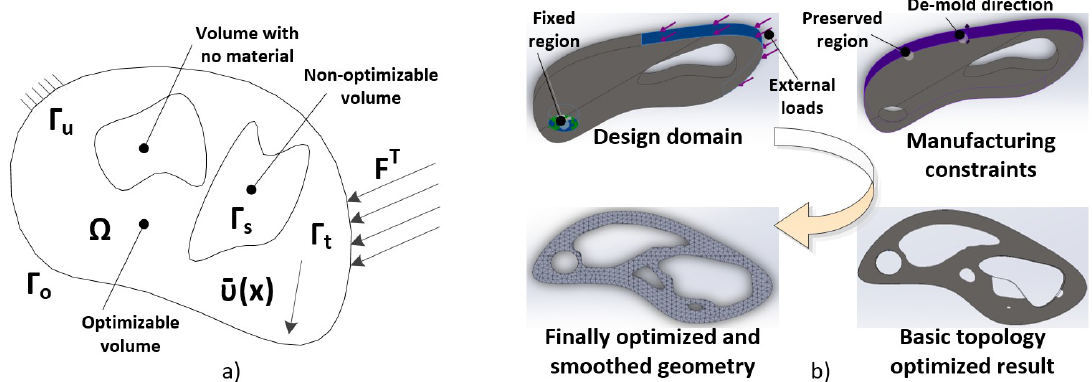
Figure 1. (a) Generalized shape design problem of finding the optimal material distribution in the 3D domain, and (b) topology optimization process steps.